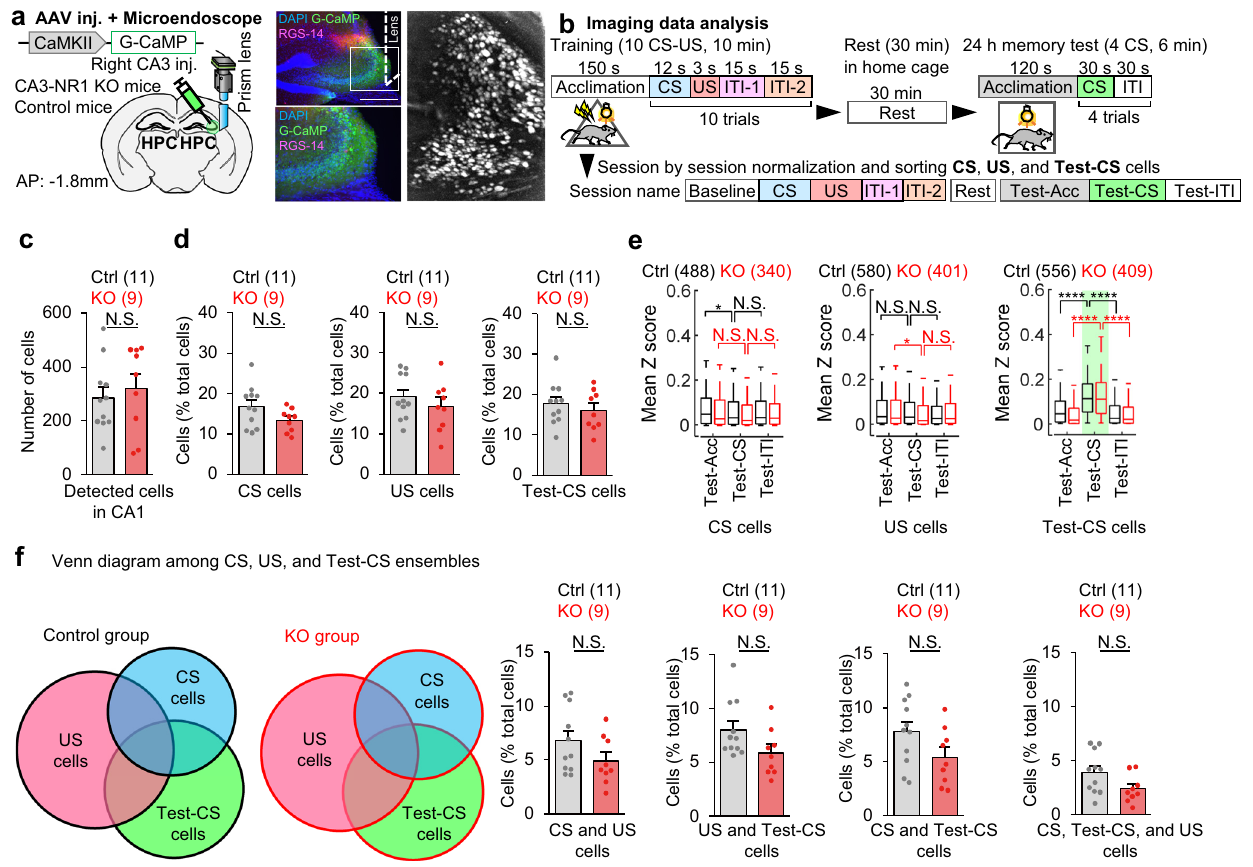
Fig. 5 | CA3-NR1 KO mice exhibited normal CA3 ensemble structure. a Left, experimental design. Right, coronal section of the hippocampus with G-CaMP- expressedcells(green)inCA3andimmunostainedwithanti-RGS-14(red).RGS-14is a marker for CA2 and stacked dF/F images acquired through the microendoscope over entire recording sessions of imaging in the hippocampus. Similar expression patternwascon fi rmedatleast5timesindependently.Scalebar,500 μ m. b Imaging dataanalysisscheme.Ineachcell,Ca2 + dataisclassi fi edintoninesessions,andthe calculatedmeanz-scoreisconsideredtorepresentresponsivenessandsortedinto CS-, US-, and Test-CS-responsive subpopulations. c Columns comparing the number of detected cells during CA3 imaging in control and CA3-NR1 KO mice. d Columns comparing percent of ensemble sizes in CS-, US-, and Test-CS- responsive subpopulations between control and KO mice. e Box plots comparing mean z-scores of long-term memory test sessions between genotypes in CS-, US-, and Test-CS-responsive subpopulations (two-tailed paired Wilcoxon